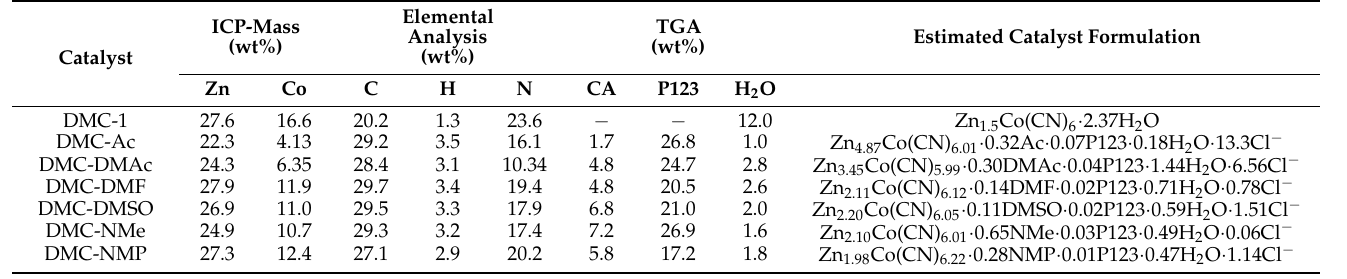
Table 2. Elemental analysis of the DMC catalysts.